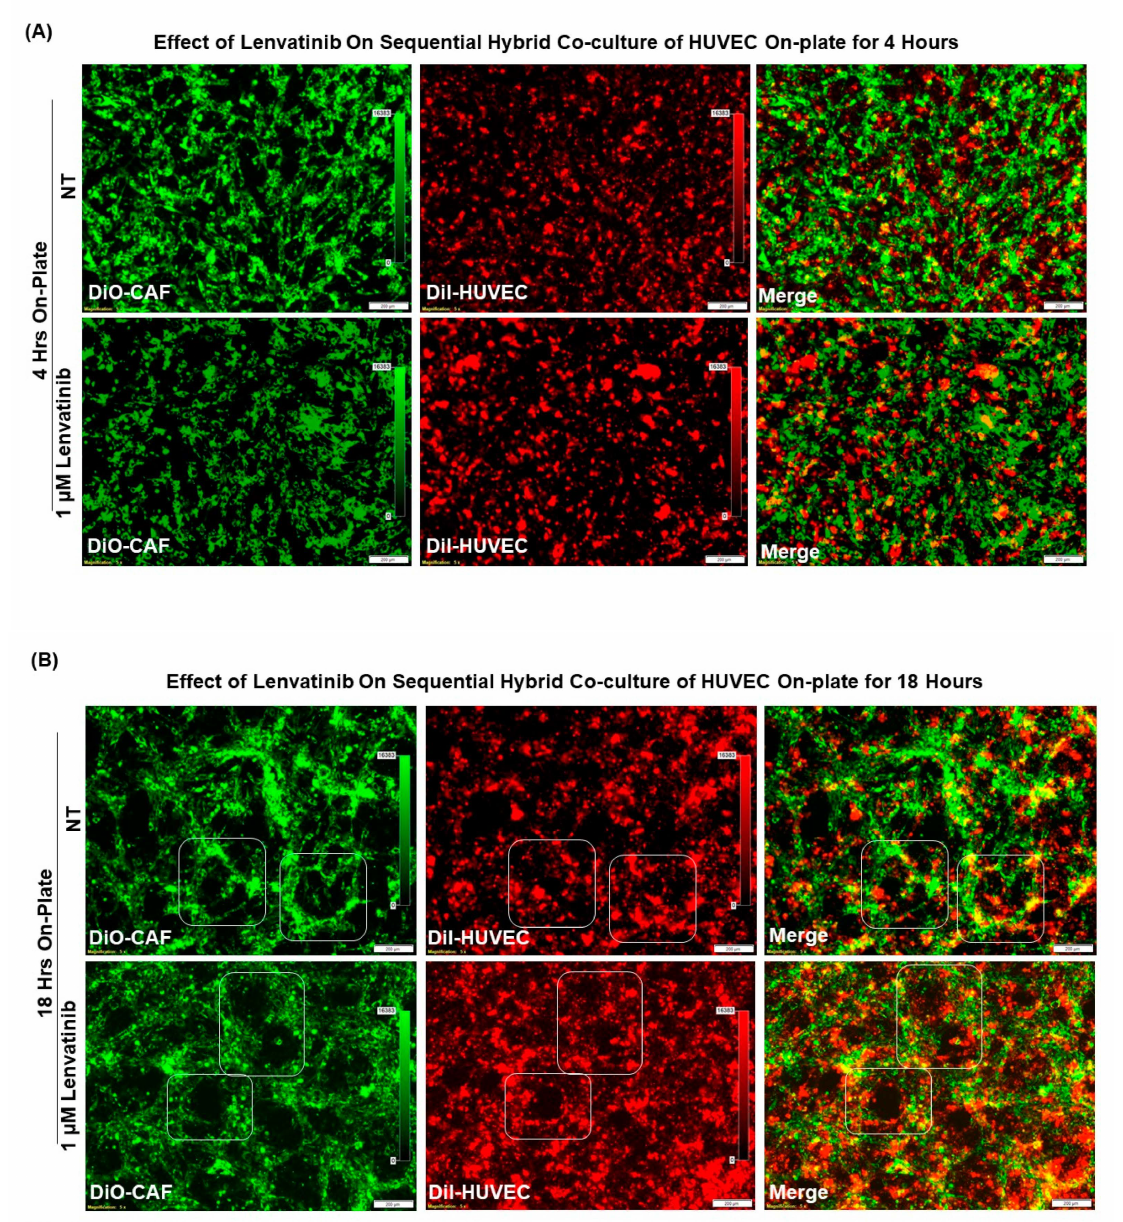
Figure 10. Effect of Lenvatinib on ex vivo “on − plate” sequential hybrid co − culture of HUVEC on Patient − Derived primary ovarian CAF for 4 and 18 h: We tested the effect of lenvatinib on sequential Hybrid Co-Culture of HUVEC “on-plate for 4 h ( A ) and for 18 h ( B ). Please note the cord formation at 18 h of co-culture, as shown by square boxes on the